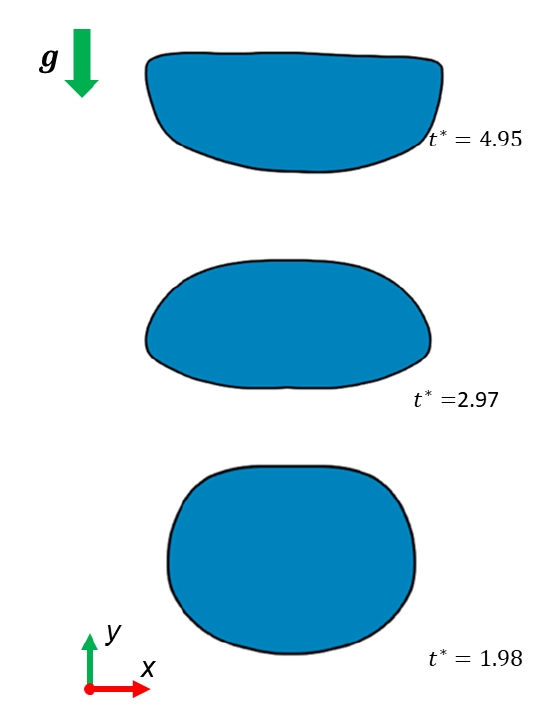
Figure 16. B3 He bubble in PbLi represented through contour r α = 0.5.